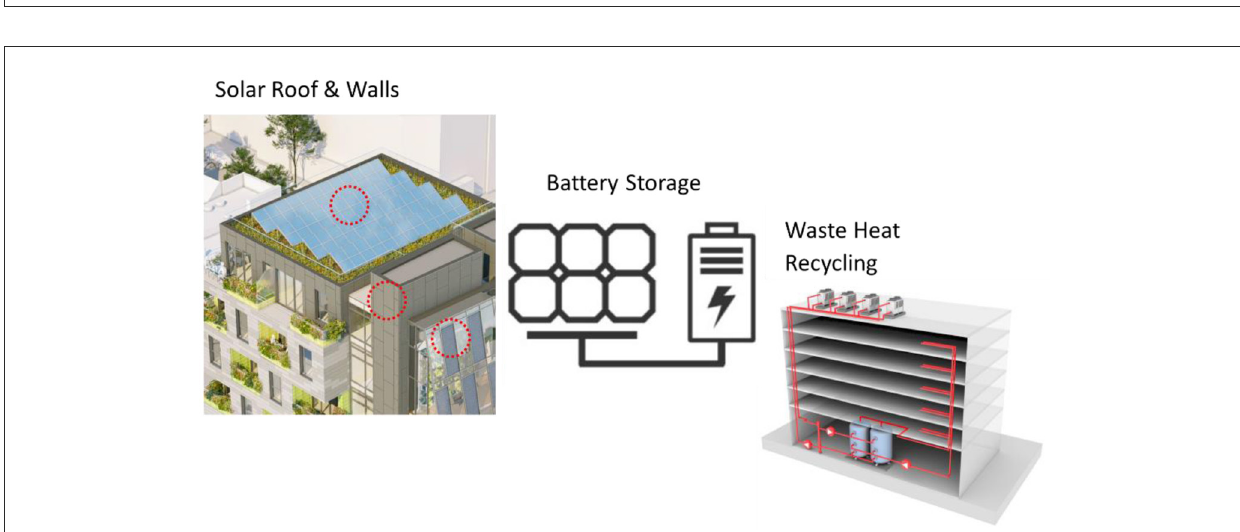
FIGURE6 Images presented to focus group participants with verbal explanation of broader proposed energy management strategy for the building. Image reproduced with kind permission from the architects.